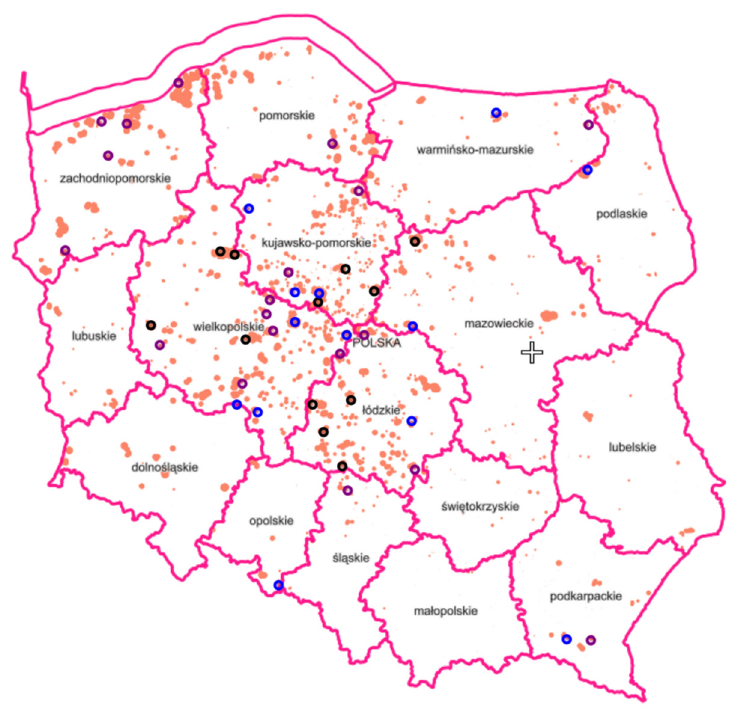
Figure 1. Towns and cities covered by ‘exclusion zones’ around wind turbines in Poland in 2022. (at least 25% of the area covered) [59]. Circles: black—75–100% of the area; violet 50–74%; blue 25–49%.